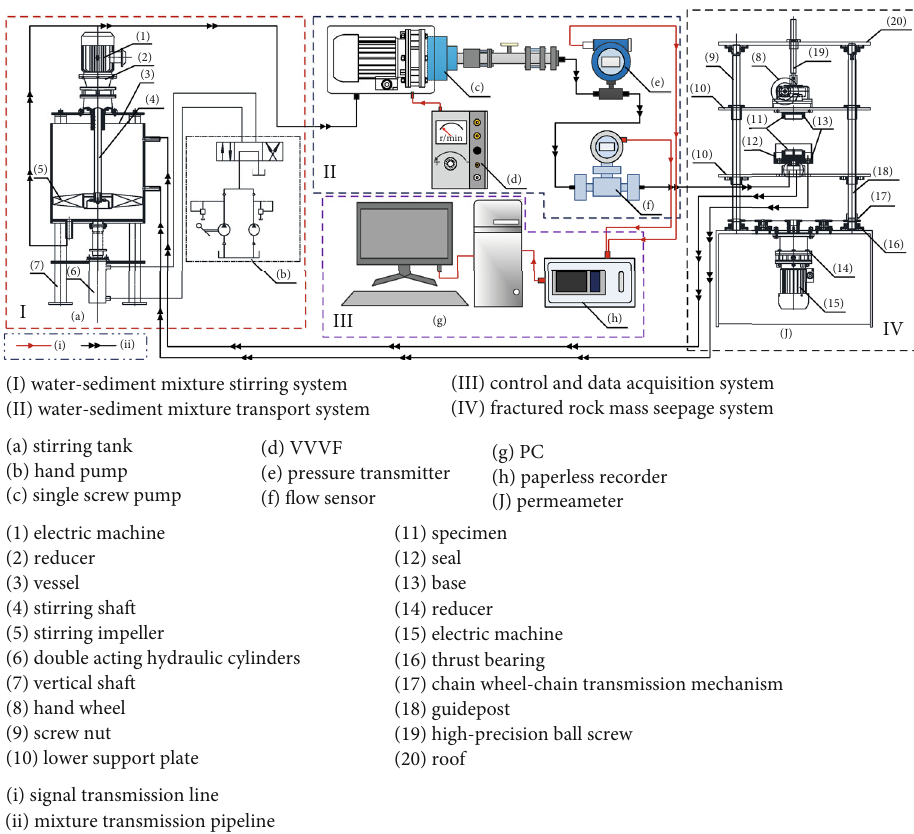
Figure 2: Testing system of water-sediment mixture seepage in rock fractures. (I) Water-sediment mixture stirring system. (II) Water- sediment mixture transport system. (III) Control and data acquisition system. (IV) Fractured rock mass seepage system. (a) stirring tank,